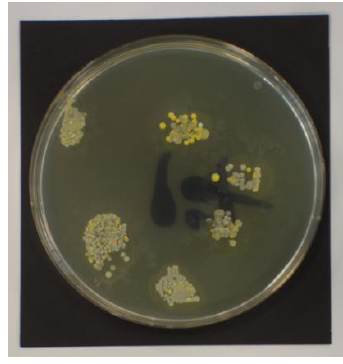
Figure 3. Example of a child's fingerprint on an agar plate.